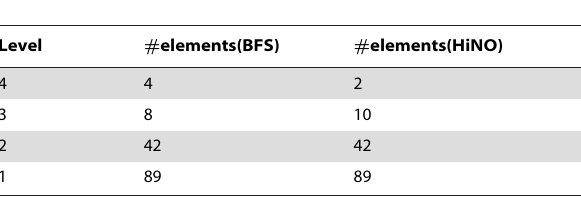
Table 3. Level distribution of the TRN in E. coli.